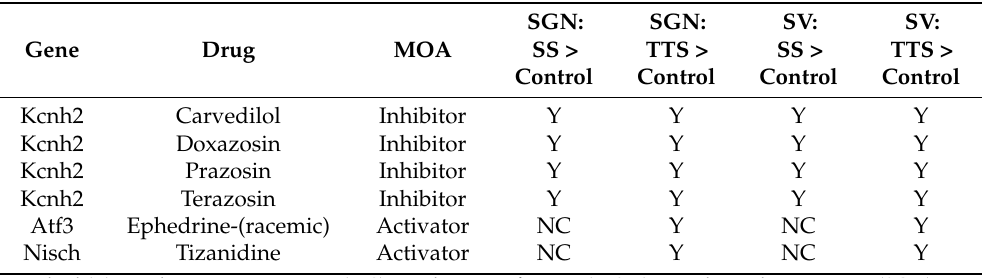
Table 5. FDA approved, orally administered alpha and beta blockers that interact with steroid- responsive genes in the cochlea localized to SGN and SV cell